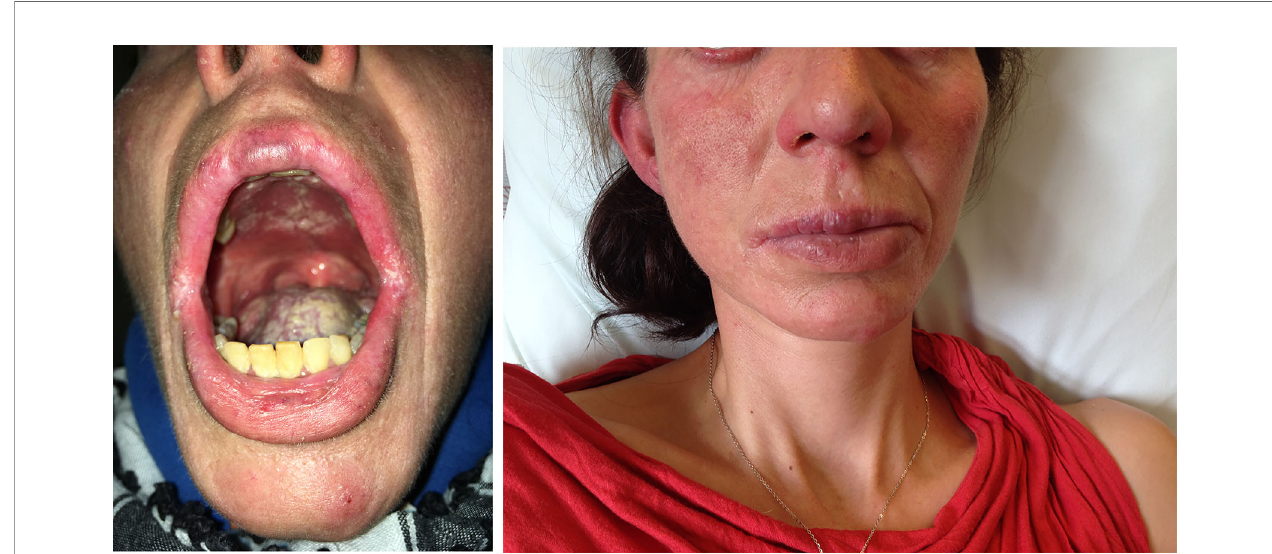
FIGURE 1 | Chronic oral candidiasis (left, photo taken in February 2018) associated with diffuse in fl ammatory papules and blepharitis along with cutaneous and ocular rosacea-like demodicosis (right, photo taken in June